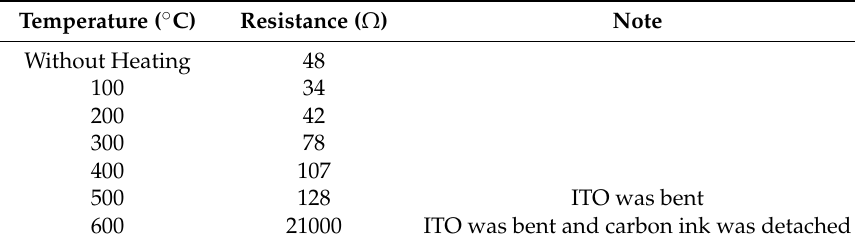
Table 2. Resistance of curring